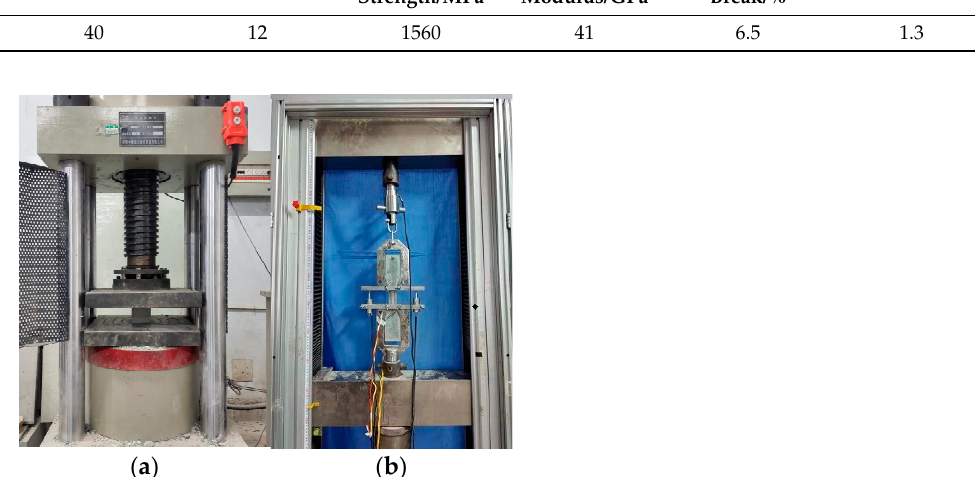
Figure 4. Test of ECC mechanical properties. ( a ) compression test; ( b ) tension test.